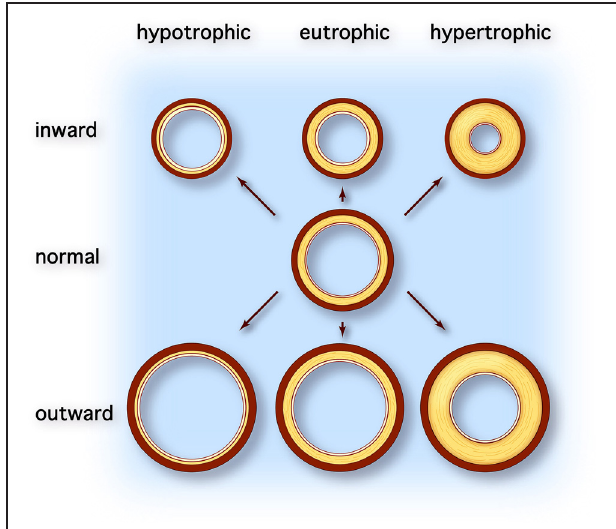
FIGURE 1 | Types of vascular remodeling. Adapted from Mulvany et al. (1996). Different types of arterial remodeling can be distinguished: hypotrophic (left column), eutrophic (center column) and hypertrophic (right column). In addition remodeling can be either inward or outward. Hypotrophic remodeling results in a relative thinner wall and a lower wall-to-lumen ratio. Conversely hypertrophic remodeling is characterized by thickening of the vascular wall due to cellular hyperplasia and/or hypertrophy or deposition of extracellular matrix material and results in increased wall-to-lumen ratio. When the diameter of the vessel changes but the wall-to-lumen ratio remains the same it is called eutrophic remodeling. All types of arterial remodeling can occur in cardiovascular disease, depending on the underlying pathophysiology (e.g., aneurysm or hypertensive arterial stiffening) and arterial site (e.g., central elastic arteries vs. peripheral resistance